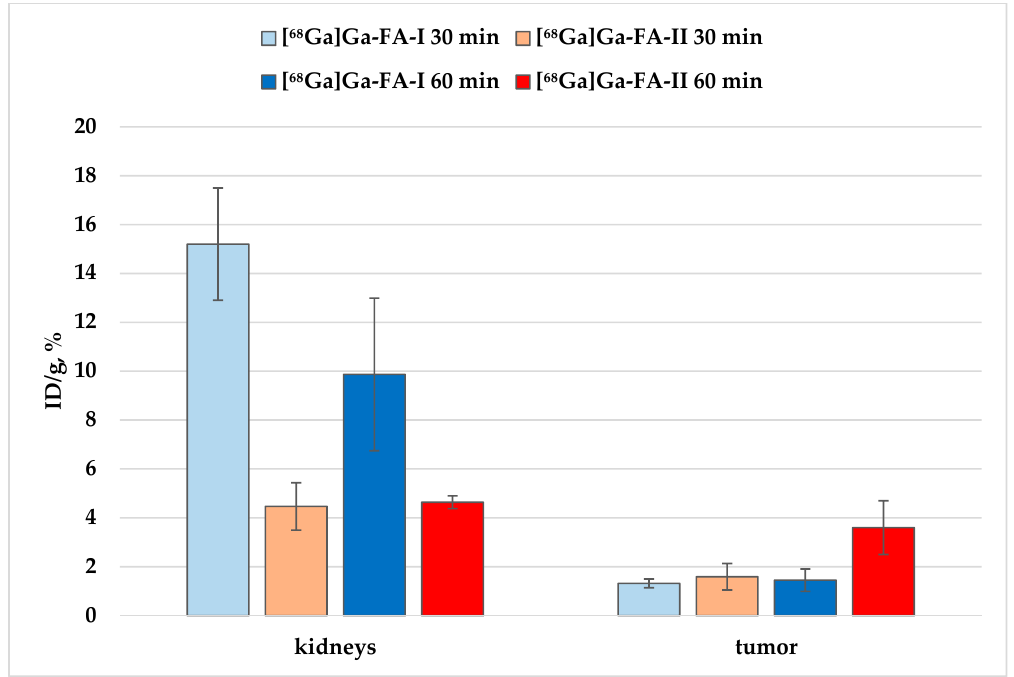
Figure 6. Accumulation of [ 68 Ga] Ga-FA-I and [ 68 Ga] Ga-FA-II in kidneys and KB-tumor xenografts.